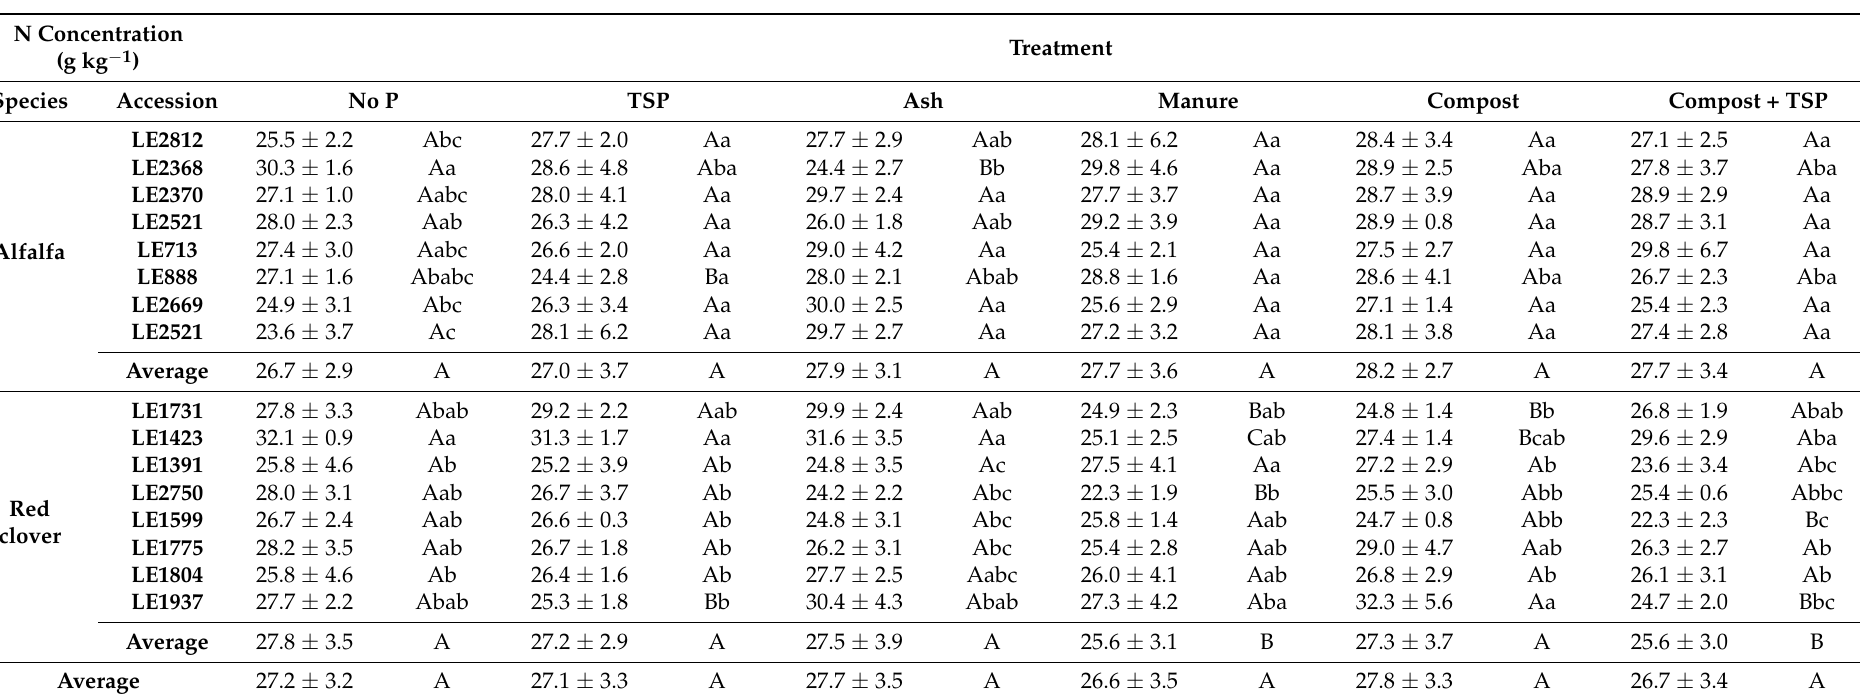
Table 6. Nitrogen (N) concentration of selected accessions of alfalfa and red clover of the six studied treatments (no P, TSP, ash, manure, compost, and compost + TSP) in